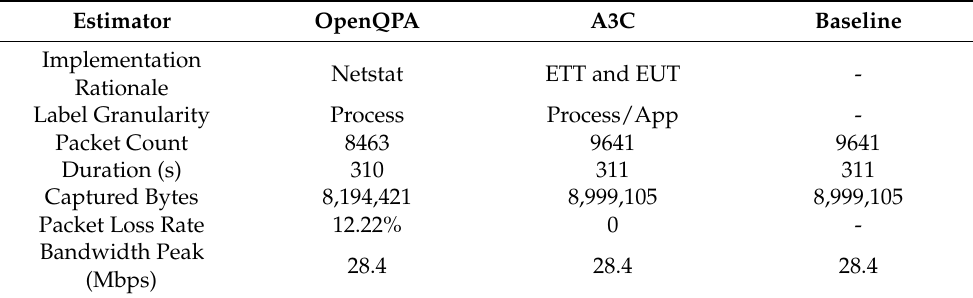
Table 3. Quantitative comparison of traffic sample construction in